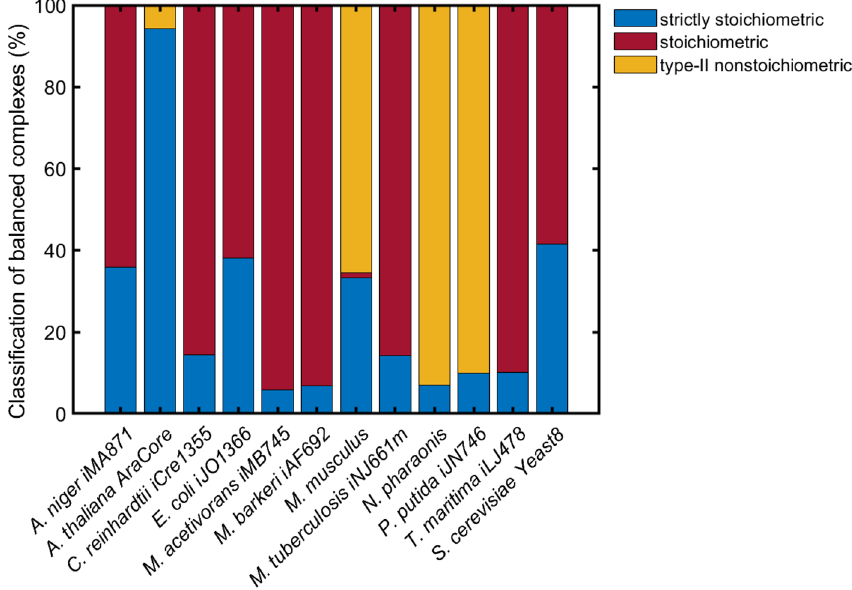
Figure 5. Classification of balanced complexes into strictly stoichiometric, stoichiometric and type-II nonstoichiometric. Balanced complexes from twelve genome-scale models of organisms across kingdoms of life are classified and the percentage of model BCs that fall into the respective class is presented. Type-I nonstoichiometric BCs are not present in the analyzed models since blocked reactions were removed from the networks prior to analyses. For model references, see Supplementary